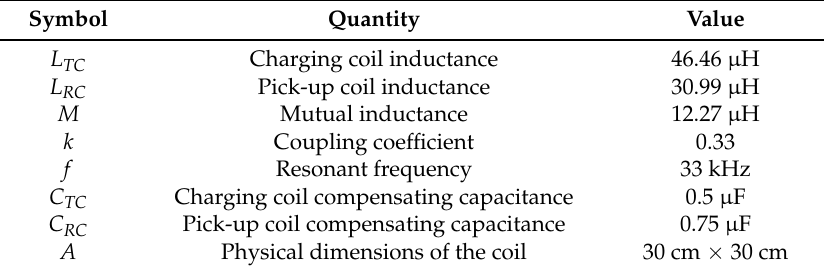
Table 2. Parameters of the inductive power transfer (IPT) system.